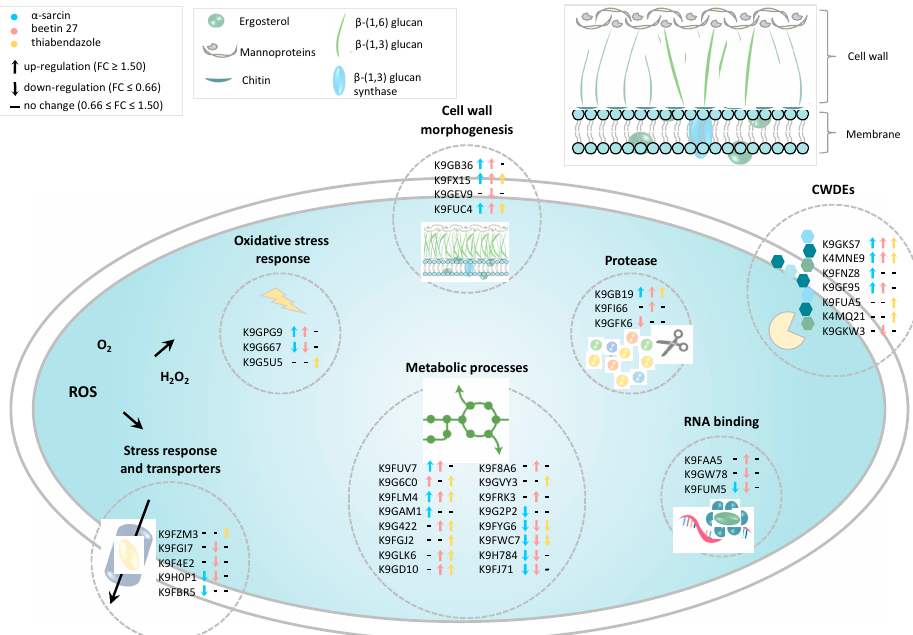
Figure 4. Functionally grouped network of enriched molecular function categories for a subset of differentially expressed proteins generated using the ClueGO Cytoscape plug-in. The proportion of shared proteins between terms was evaluated using kappa statistics. GO terms are depicted as nodes whose size represents the term enrichment significance.